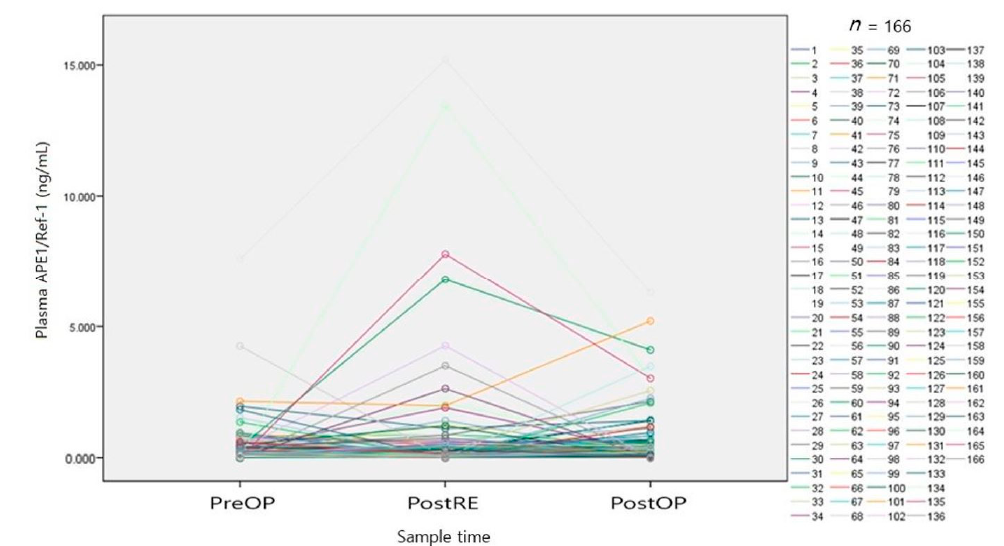
Figure 2. Test values of overall cohort (166 patients) in spaghetti plot format. PreOP, preoperative sample; PostRE, postresection sample; PostOP, postoperative sample.